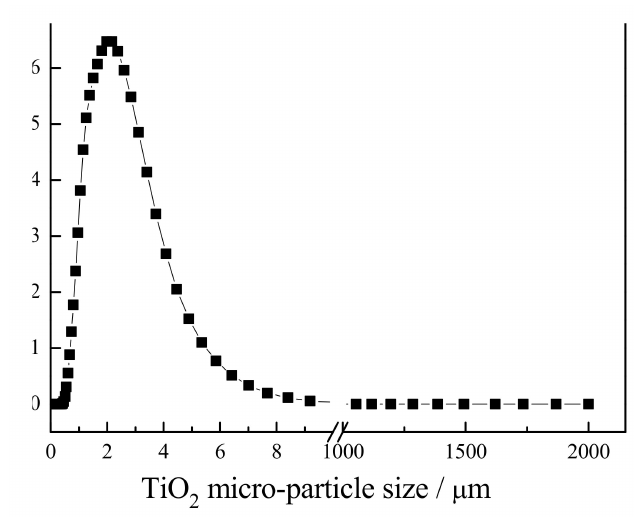
Figure 1. Particle size distribution for TiO 2 micro-particle.